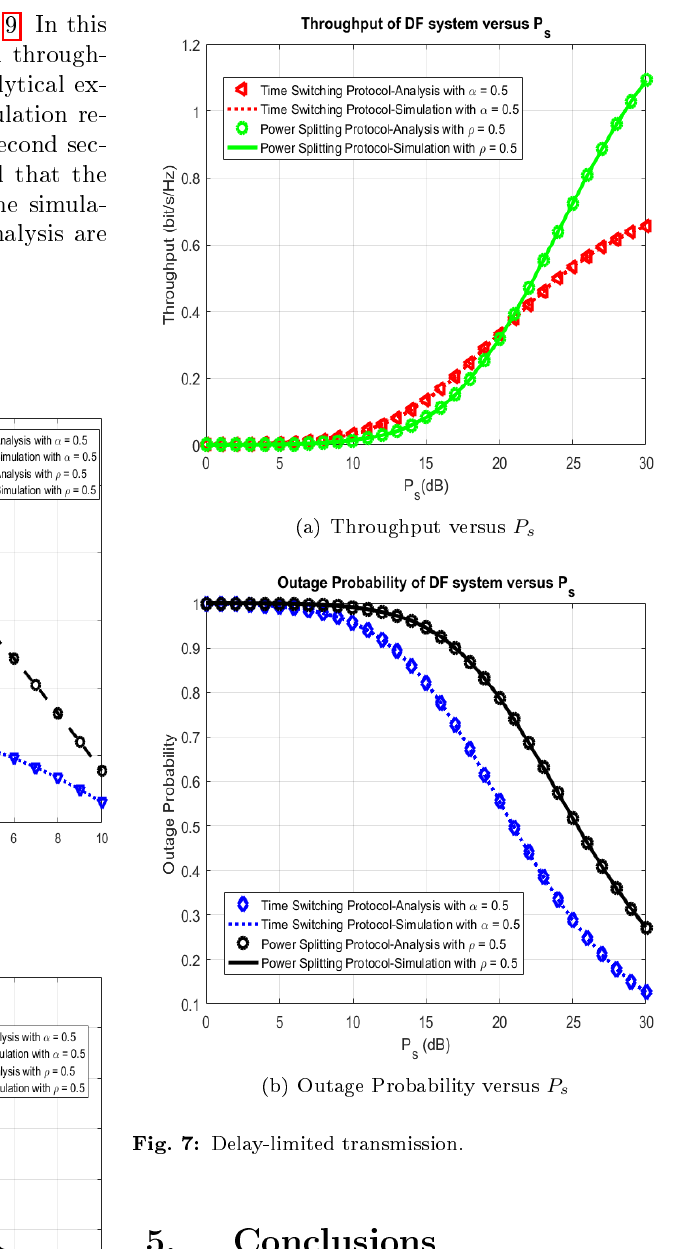
Fig. 7: Delay-limited